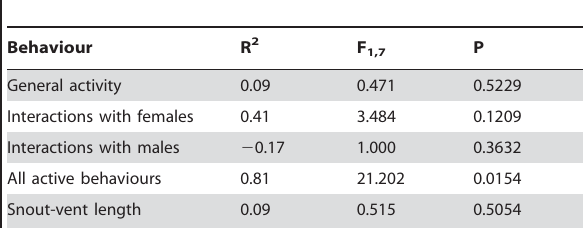
Table 1. Regression analyses of the active behaviour categories, all active behaviours combined and male body size, relative to the total number of offspring